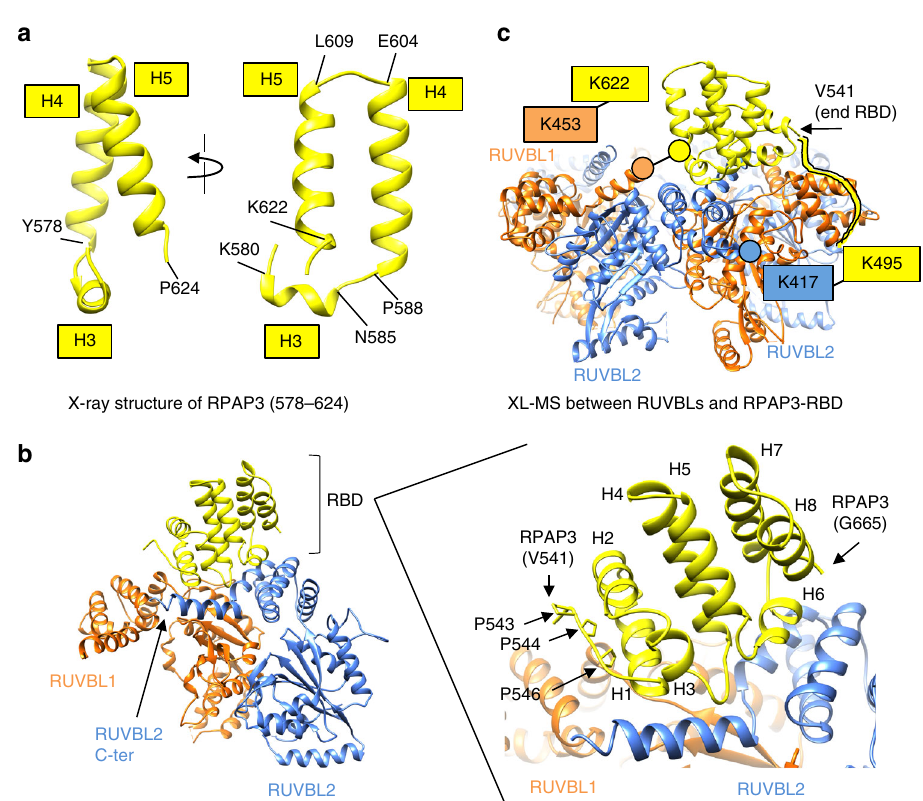
Fig. 5 Structural model of RUVBL1 – RUVBL2 – RBD. a Crystal structure of a fragment of the RBD domain. H3, H4, and H5 stand for helices 3, 4, and 5, respectively. b Structural model of RUVBL1-RUVBL2-RBD. Color codes: RUVBL1 (orange color), RUVBL2 (blue color), and the RBD (yellow color). The panel on the left shows only two subunits from RUVBL1 – RUVBL2 as seen from the interior of the ring. The panel on the right is a close-up view of the RBD to highlight the N-terminal region and the positioning of the 8 helices in the structure (H1 to H8). Scale bar, 2.5 nm. c Two cross-links identi fi ed by XL-MS between RUVBL1 – RUVBL2 and the RBD are indicated on the structural